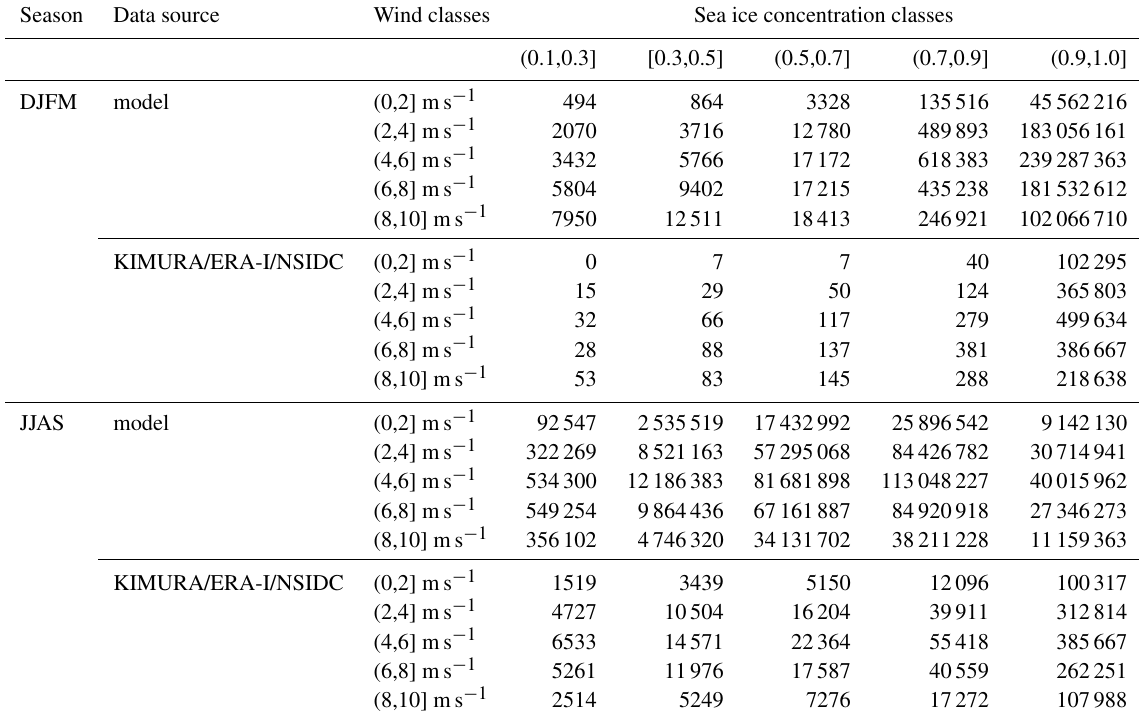
Table 1. The sample sizes of sea ice drift speed data under different 10m wind speed and sea ice concentration classes in Fig. 4. In the labels of different sea ice concentration and 10m wind speed classes, “(” means exclusive and “]” means